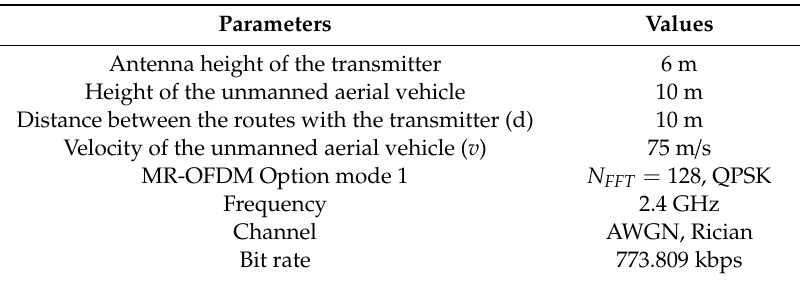
Table 2. Characteristic parameters for simulation.